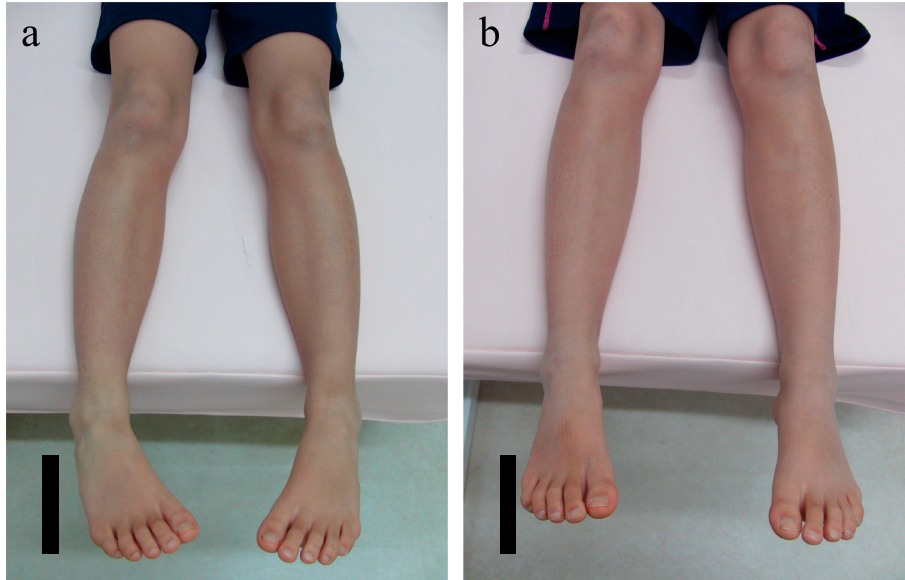
range. * p < 0.01, comparison with pretreatment values.